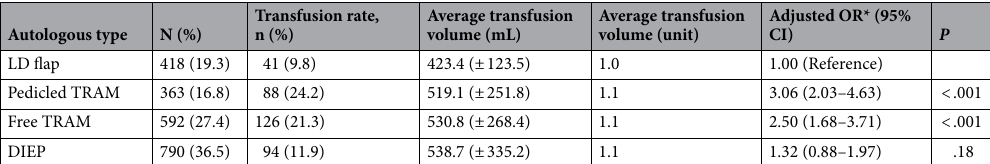
Table 3. Transfusion rates, volumes, and relative risks according to the type of surgical method in immediate autologous breast reconstruction patients. OR odds ratio, LD latissimus dorsi, TRAM transverse rectus abdominis, DIEP deep inferior epigastric perforator, CI confidence interval. *Estimated by logistic regression adjusted for age, region, insurance type, medical institution type, and comorbidities (including hypertension, diabetes mellites, coronary artery disease, chronic obstructive pulmonary disease, end-stage renal disease, anemia, and liver disease).